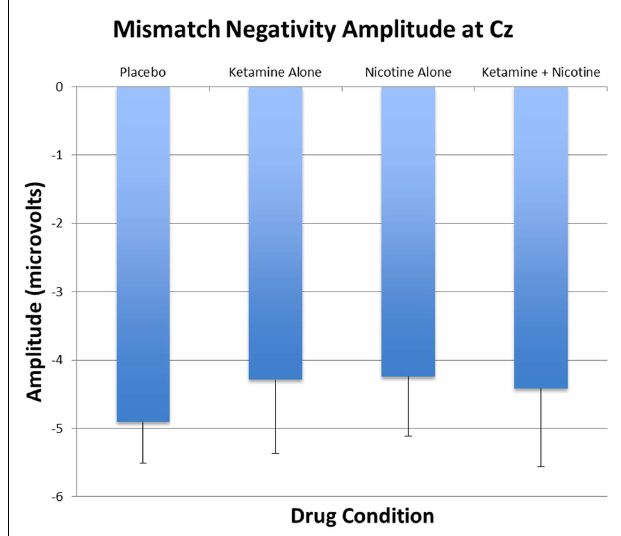
FIGURE 4 | Mean and standard errors for MMN amplitudes recorded at Cz are plotted for the four test days